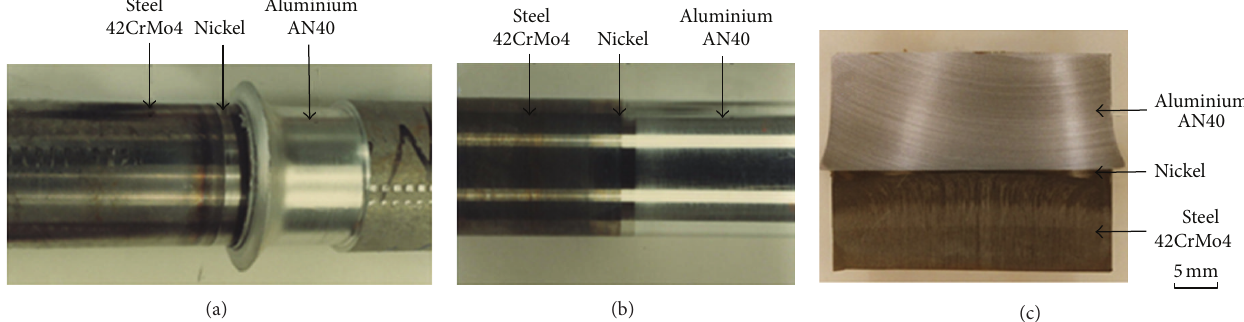
Figure 23: The view of the joint after the friction welding of 42CrMo4 steel-AN40 alloy with nickel interlayer, directly after the welding (a), after removal of the flash (b), and the macrostructure of the joint (c).